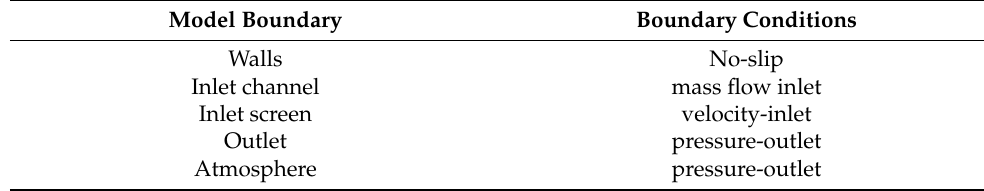
Table 2. Boundary Conditions Applied.